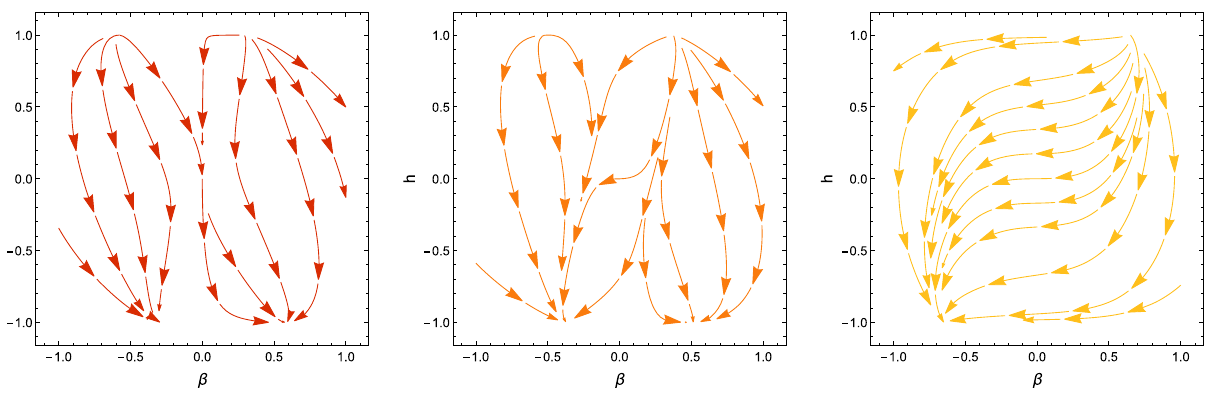
, β = 0 and for three different values of ω g 3